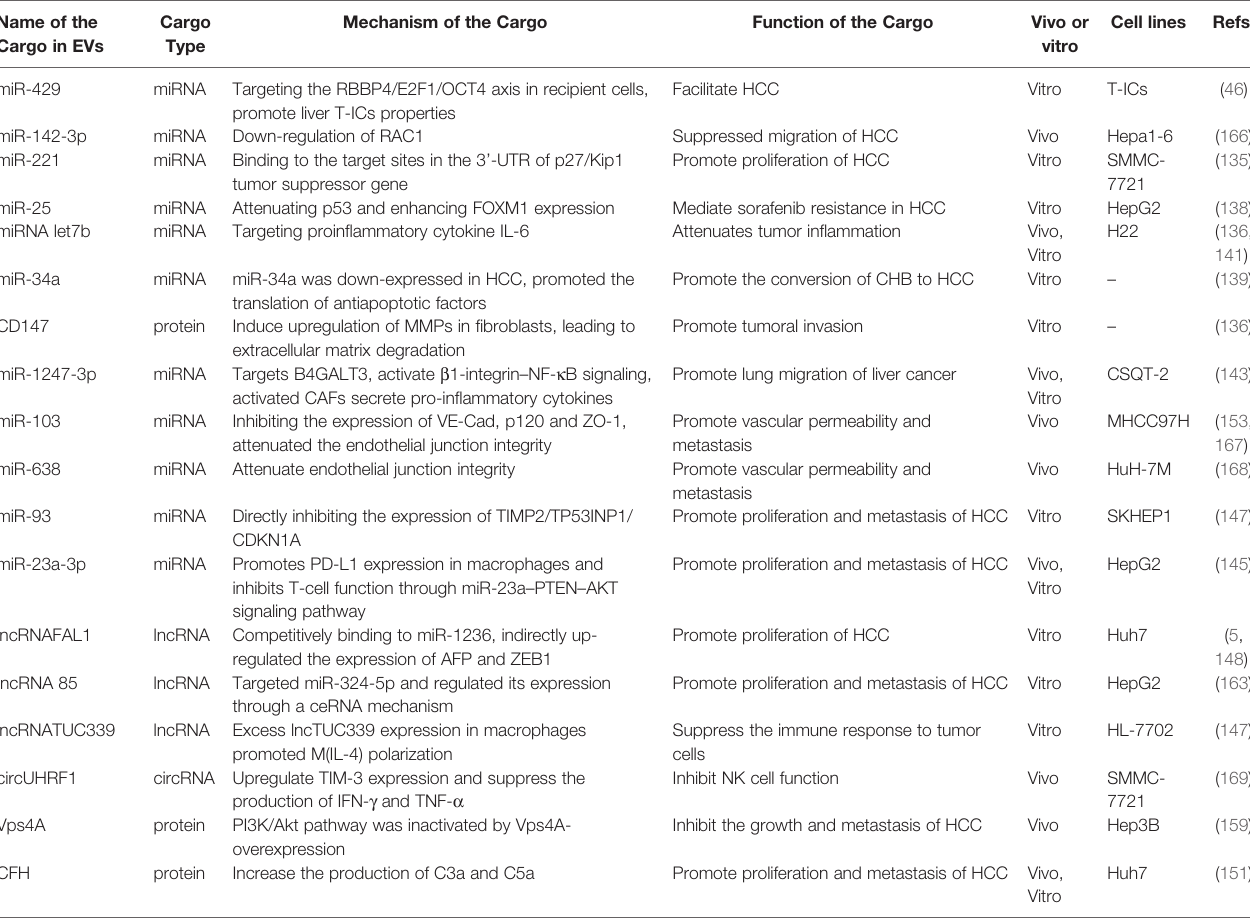
TABLE 2 | The cargos and functions of EVs related with HCC. Name of the Cargo in